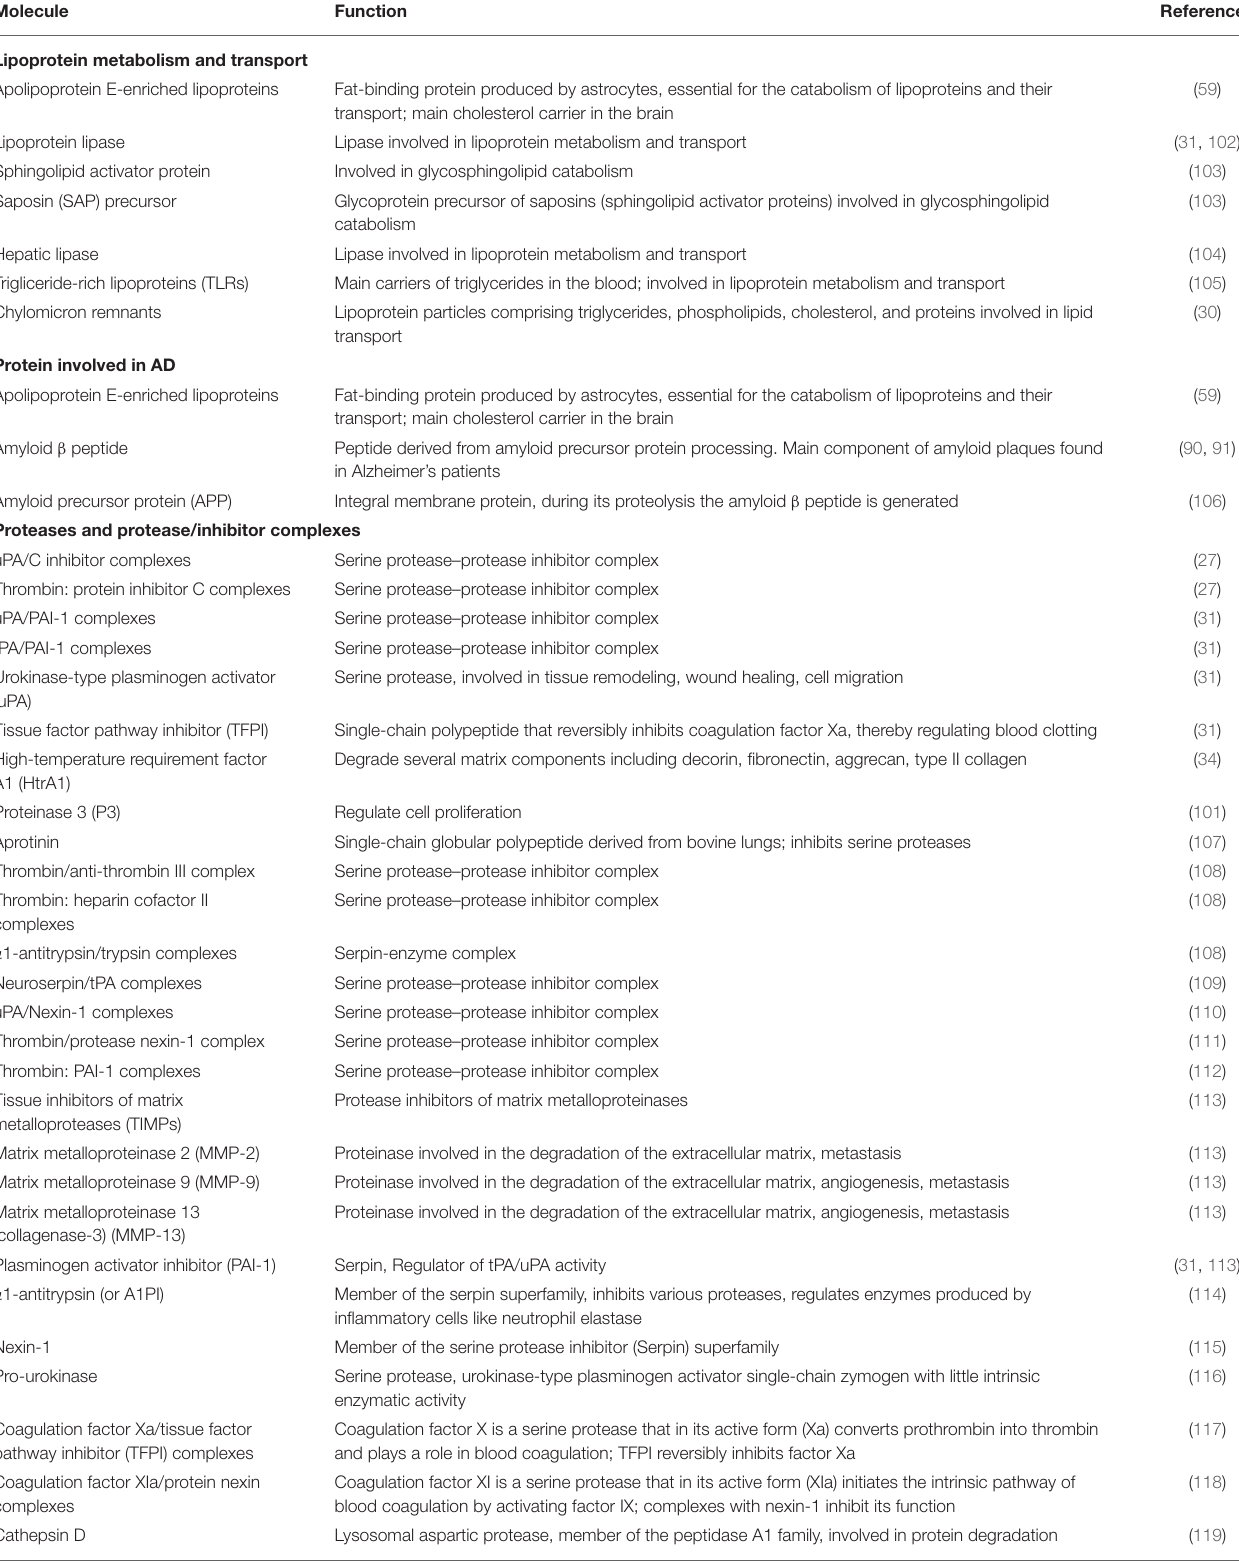
TABLE 1 | Ligands that binds to extracellular domain of LRP1.